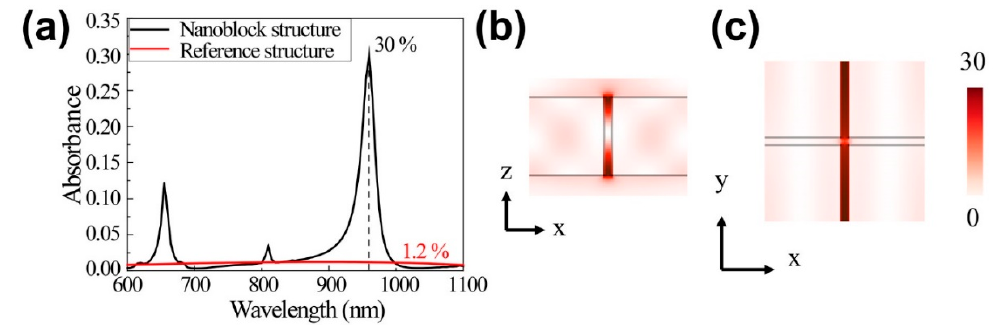
Figure 2. ( a ) Simulated absorption spectra for the proposed upconversion (UC) slot structure and reference film; the UC device exhibits emission and absorption resonances at 660 and 970 nm, respectively; ( b ) and ( c ) electric field intensity profiles for 970 nm incident light; maximum field intensity is almost 30 times that of the incident light.